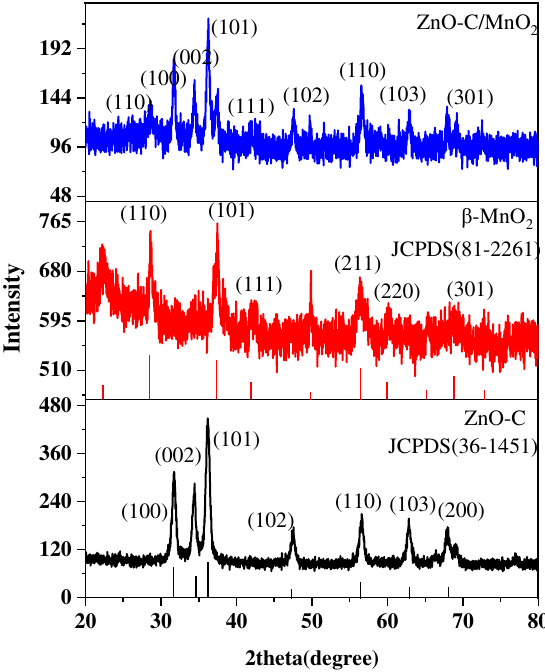
Figure 1. XRD patterns of ZnO‐C, MnO 2 , and ZnO‐C/MnO 2 .